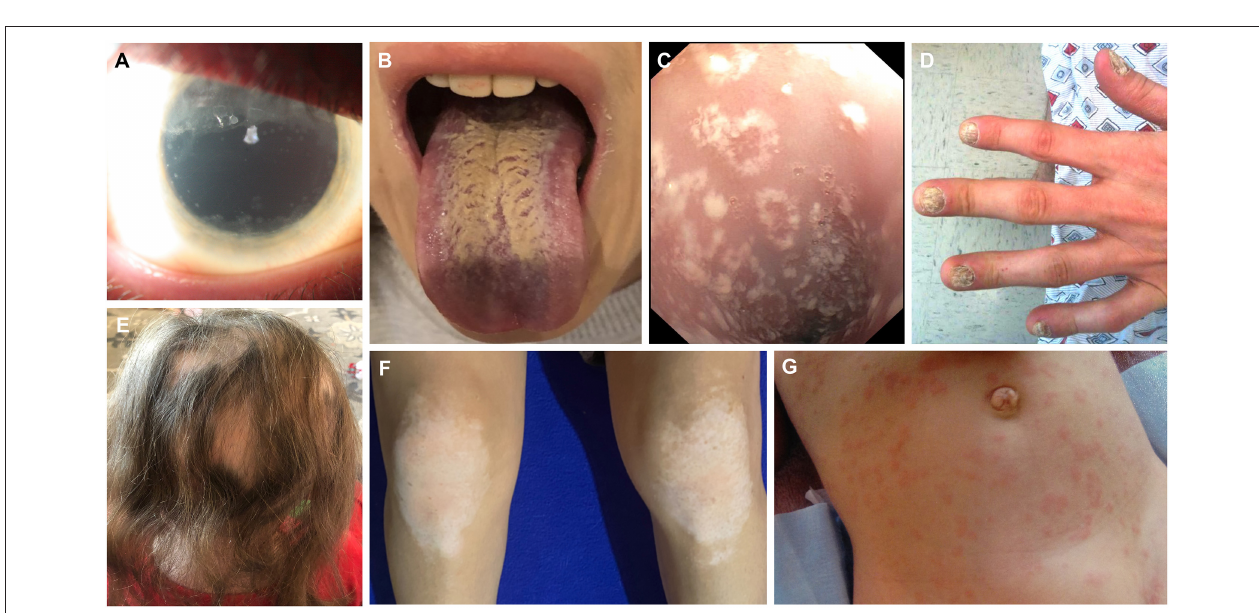
FIGURE 3 | Clinical images depicting ophthalmologic, mucocutaneous and dermatologic manifestations in APECED patients. (A) Extensive keratopathy secondary to chronic keratoconjunctivitis. (B) Depiction of Candida chelitis and thrush affecting the tongue. (C) Endoscopic visualization of the esophagus demonstrating Candida esophagitis. (D) Nail dystrophy. (E) Alopecia areata. (F) Vitiligo affecting the knees. (G) APECED rash in an infant with APECED. Image 3G is derived from Ferré et al., (